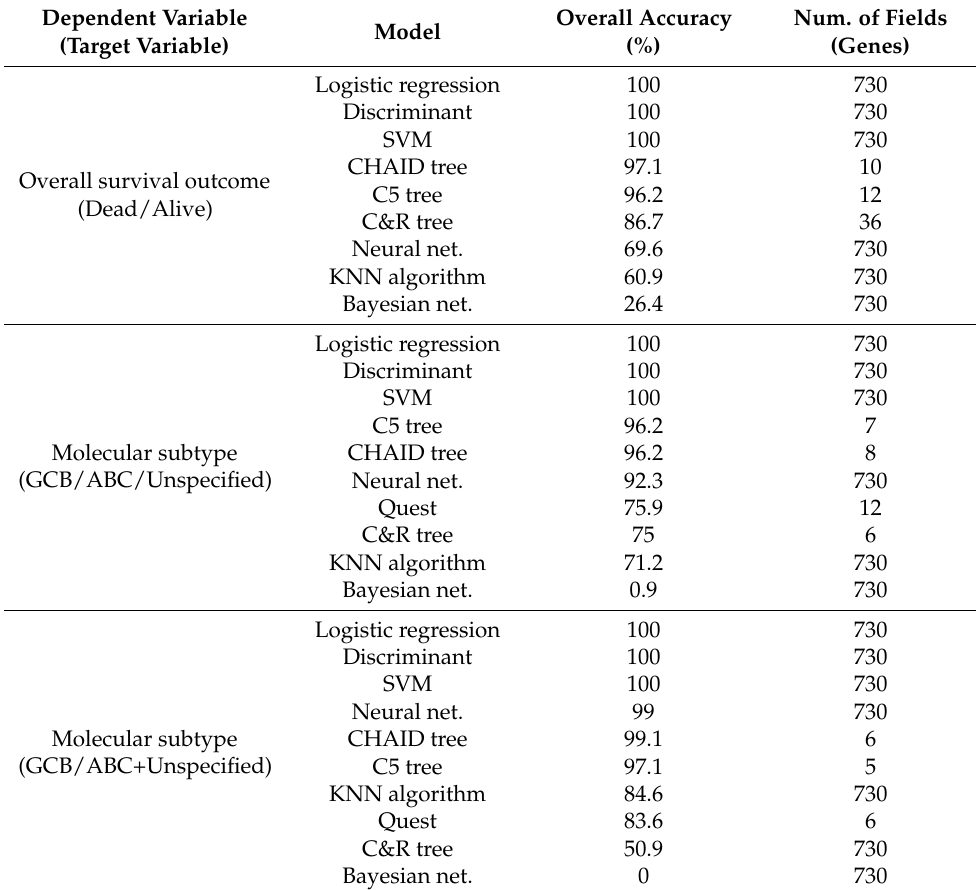
Machine learning analysis for predicting the overall survival outcome and molecular